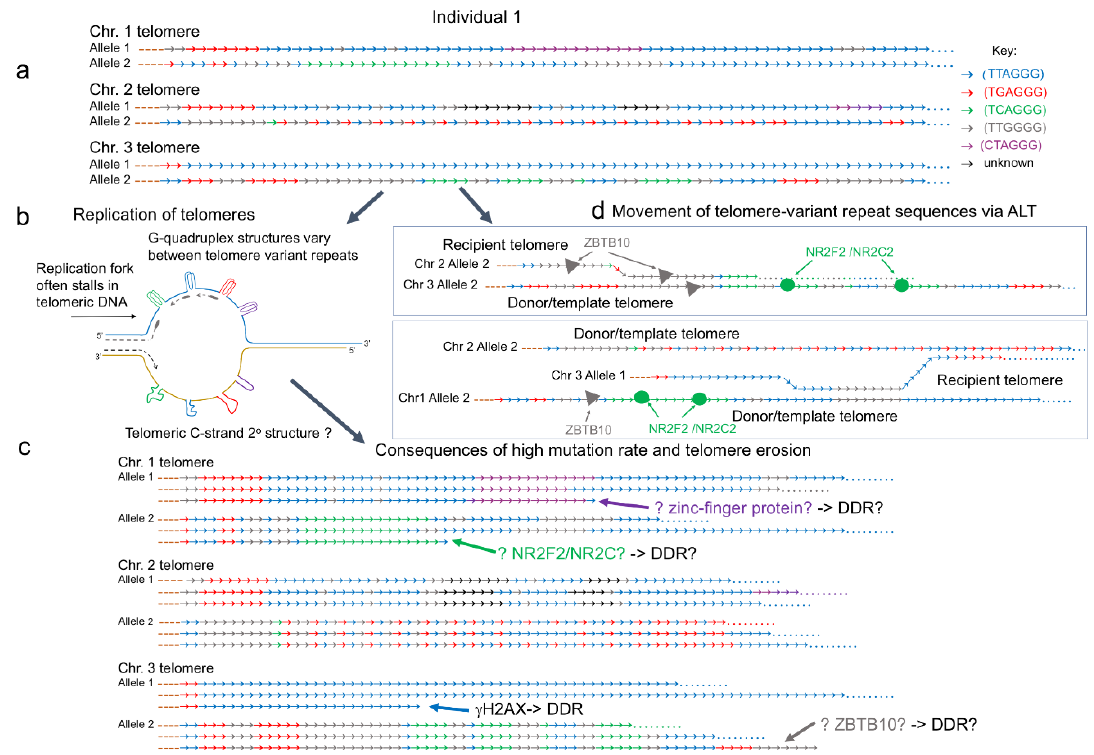
Figure 1. Mutation processes at telomeres. Examples of the interspersion patterns of the canonical (TTAGGG) and telomere-variant repeats (TVRs) commonly found at the proximal (centromeric) ends of human telomeres. ( a ) The diagram represents three telomeres on di ff erent chromosomes (Chr. 1 to 3) each with di ff erent interspersion patterns in the two alleles. While many telomeres comprise a region of degenerate repeats at the proximal end, some telomeres lack sequence variation in this region, as shown in Chr. 3 allele 1. ( b ) During S phase, the replication fork is prone to pausing or stalling as it passes through telomeric DNA. This is due to secondary structures, such as t-loops (not shown) that must be unwound. In addition, a variety of G-quadruplex structures can form on the G-rich strand. It is not known if the C-strand can also adopt secondary structures that impede replication. These obstacles contribute to high somatic and germline mutation rates that usually result in gains or losses of repeats. ( c ) Telomere lengthening by the break-induced-replication (BIR) mechanism that underlies the alternative lengthening of telomeres (ALT) moves TVRs between telomeres and can result in the distribution of the variant repeats along the full length of the telomeric DNA. The NR2F2 and NR2C2 orphan nuclear receptors can bind to (TCAGGG) n containing telomeres in ALT positive cells. Similarly, ZBTB10 has recently been shown to bind to (TTGGGG) n repeats in ALT positive cells. The binding of these proteins at telomeres may contribute to an altered DNA damage response. ( d ) The replication-driven high mutation rate at telomeres creates mosaicism within normal tissues, cancers, and the germline such that some cells carry mutated telomere interspersion patterns. In addition, the replication-dependent erosion of telomere length results in short telomeres that trigger a DNA damage response (DDR). Telomere erosion may lead to exposure of sequence-variant repeats at the end of telomeric DNA. It is not known whether this triggers specific proteins to bind to the short telomeres, for example NR2F2, NR2C2, ZBTB10, or other zinc-finger containing proteins that may modify the DDR.